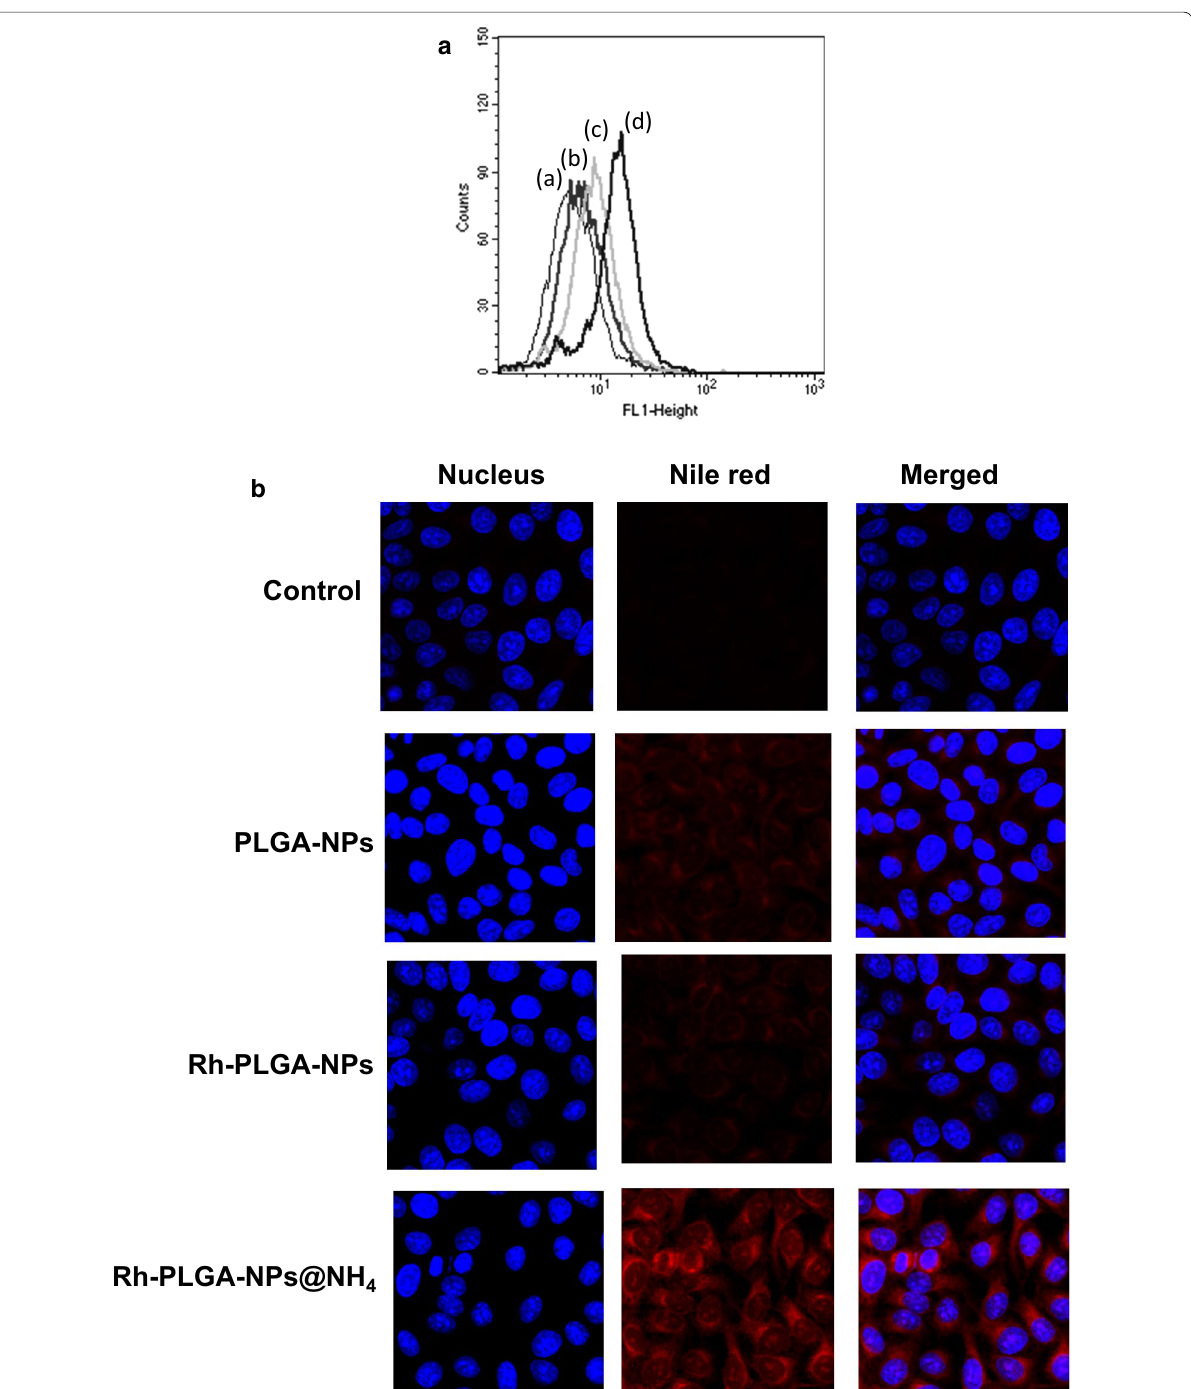
Fig. 5 Intracellular uptake of Nile red encapsulated PLGA-NPs, Rh-PLGA-NPs and Rh-PLGA-NPs@NH4 a flow cytometer analysis b confocal